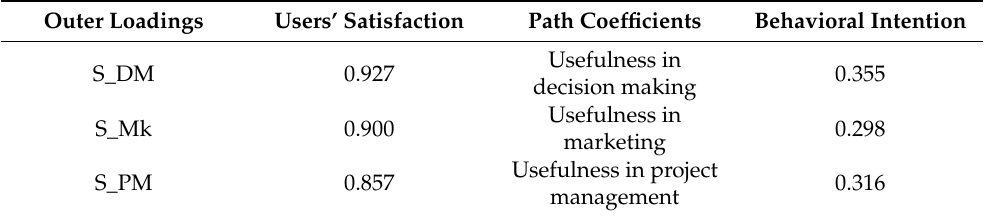
Table 6. Outer loadings for users’ satisfaction in PM, Mk, and DM and path coefficients for usefulness in PM, Mk, and DM.